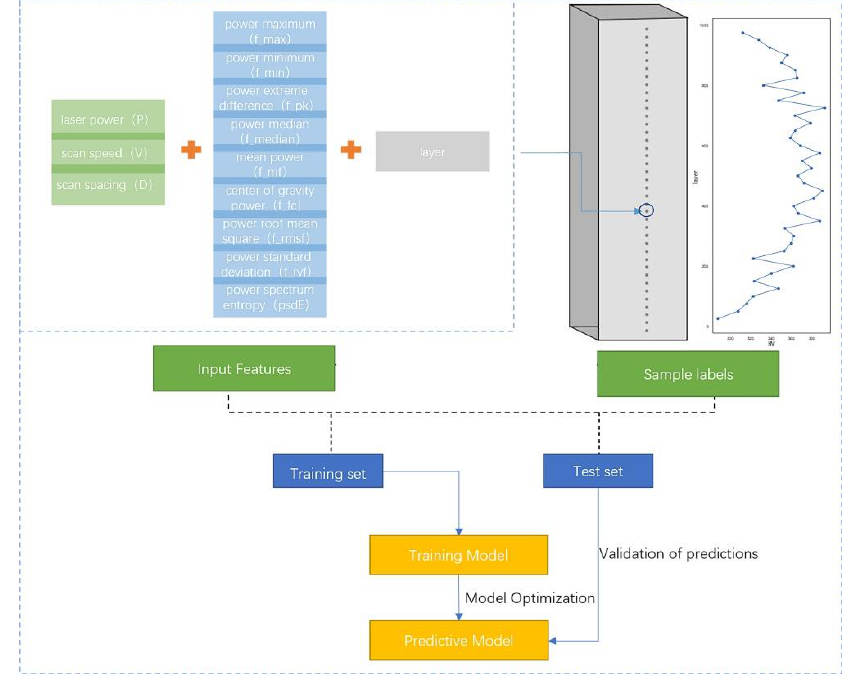
Figure 6. Model schematic.